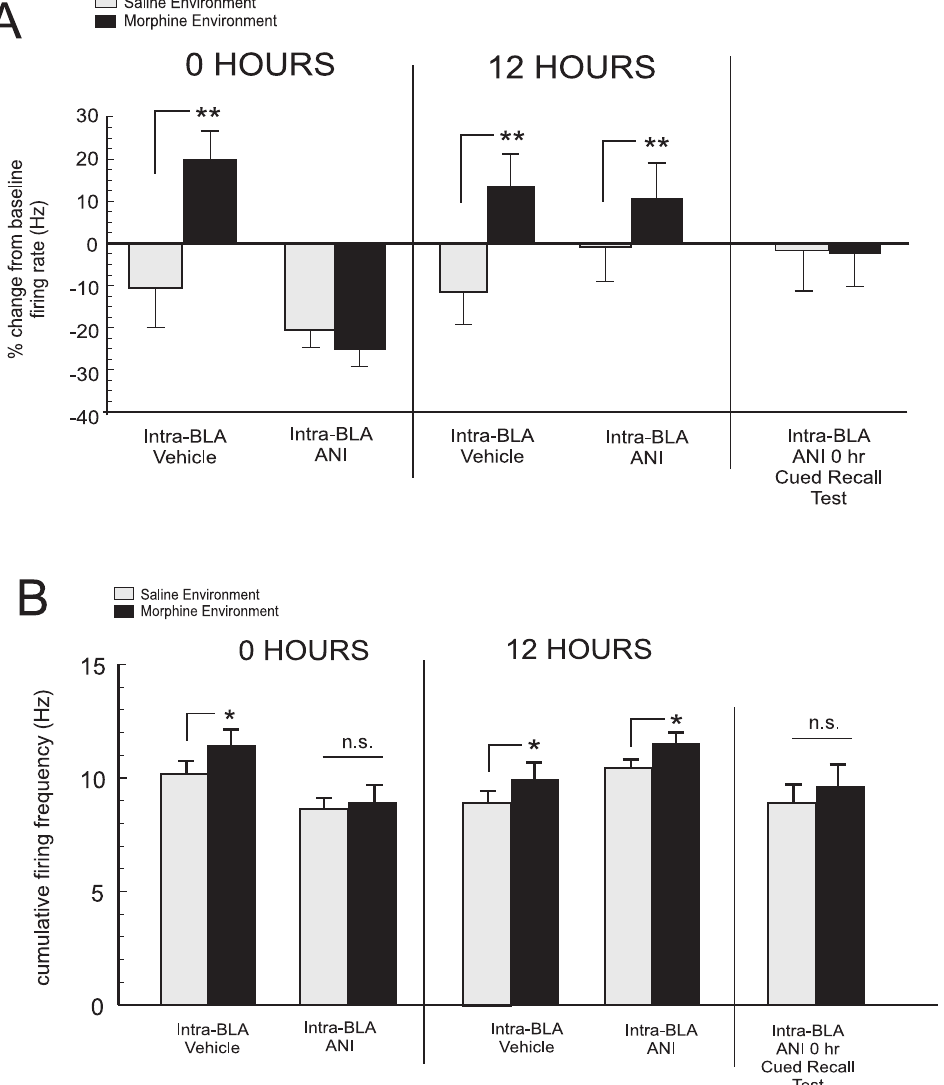
Figure 6. Effects of acute (0 hr) intra-BLA protein synthesis inhibition on mPFC neuronal associative morphine responses during CPP testing. A , When administered at 0 hrs post-conditioning, intra-BLA ANI blocks mPFC neuronal encoding of associative opiate reward memory, demonstrated by a lack of associative firing activity increases during exposure to morphine environments during CPP testing or during a morphine cued recall CPP test. In contrast, vehicle controls at 0 or 12 hrs or intra-BLA ANI administration at 12 hrs, does not block mPFC neuronal encoding of opiate reward memory, demonstrated by robust mPFC neuronal firing activity during CPP exposure to morphine-paired environments. B, Cumulative mPFC neuronal firing frequency rates are presented for the same experimental groups shown in panel A. Cumulative neuronal firing frequency demonstrates morphine-environment specific associative increases in firing rates relative to saline-paired environments in groups receiving intra-BLA vehicle at 0 or 12 hrs post-conditioning or in rats receiving intra-BLA anisomycin at 12 hrs post-conditioning. However, this associative increase in firing activity is absent in rats receiving intra-BLA anisomycin at 0 hrs post-conditioning.